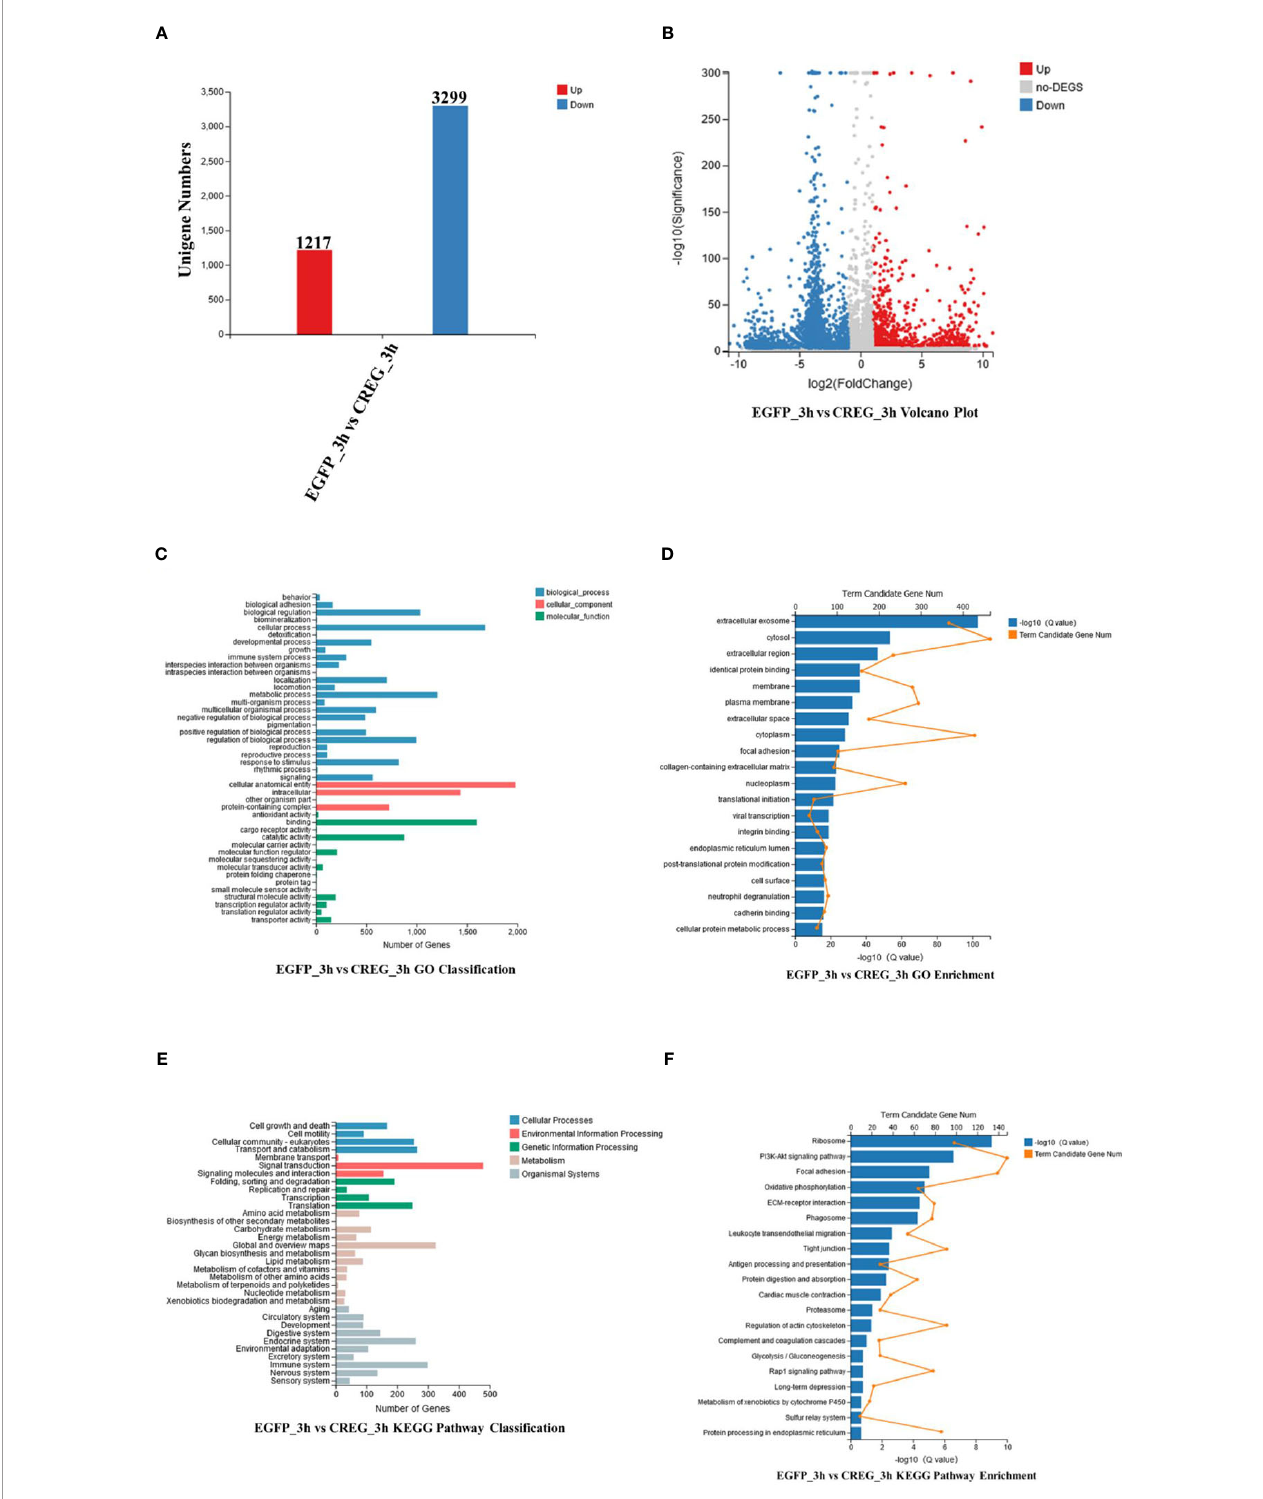
FIGURE 4 | Functional analyses of differentially expressed genes (DEGs) from transcriptomic data. (A) Statistical histogram, (B) volcano plot, (C) GO classi fi cation, (D) GO enrichment, (E) KEGG pathway classi fi cation, and (F) KEGG pathway enrichment of DEGs. Differentially expressed genes based on adjusted false-discovery rate (FDR) ≤ 0.001 and log 2FC ≥